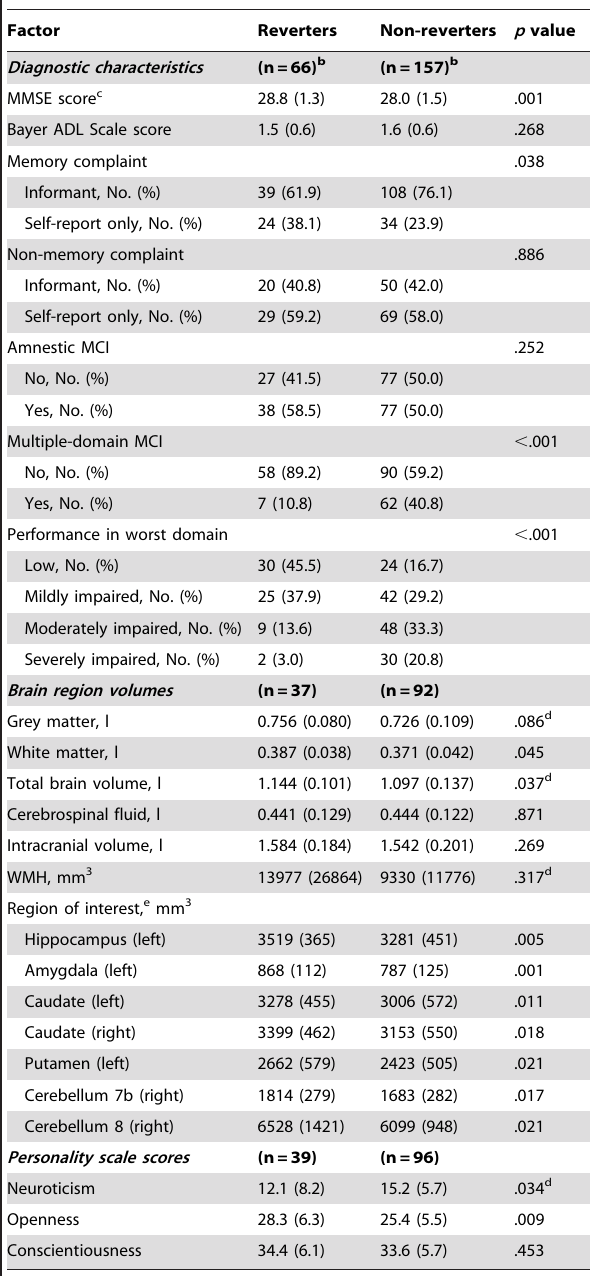
Table 2. Baseline diagnostic characteristics, brain region volumes and personality scale scores of reverters and